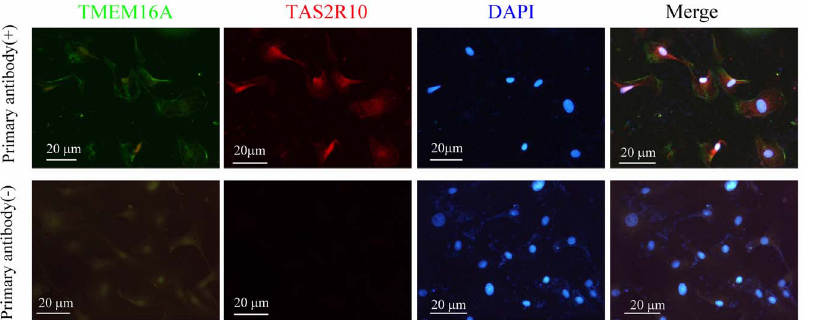
Figure 3. Colocalization of CaCC-TMEM16A and bitter receptor T2R in small intestinal epithelial cells. Immunohistochemistry was showing TMEM16A and bitter receptor TAS2R10 in rat ileum epithelial cell line IEC-18.